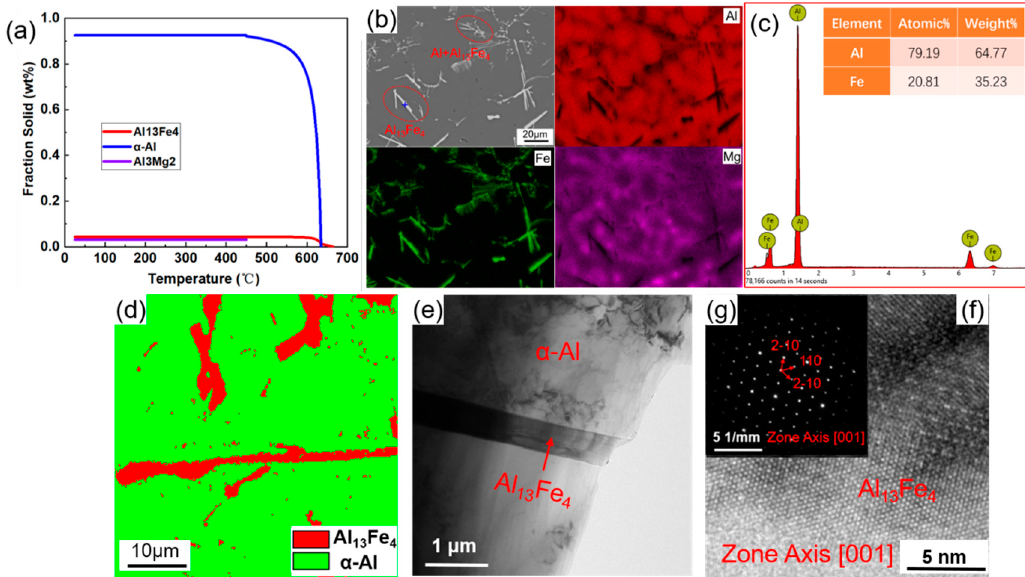
Figure 1. ( a ) Calculated solidification sequence of Al-4.5Mg-1.8Fe alloy, ( b ) microstructures and EDS map of Al alloy, ( c ) composition of Al 13 Fe 4 , ( d ) EBSD maps of A1 alloys, ( e ) TEM bright field photograph of Al 13 Fe 4 phase; ( f ) HRTEM photograph, and ( g ) the corresponding SAED pattern of Al 13 Fe 4 phase.